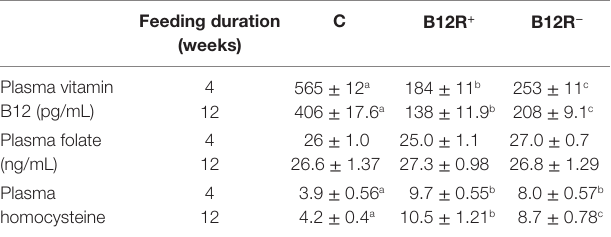
TaBle 1 | Plasma vitamin B12, folate, and homocysteine levels after 4 and 12 weeks of feeding. Feeding duration